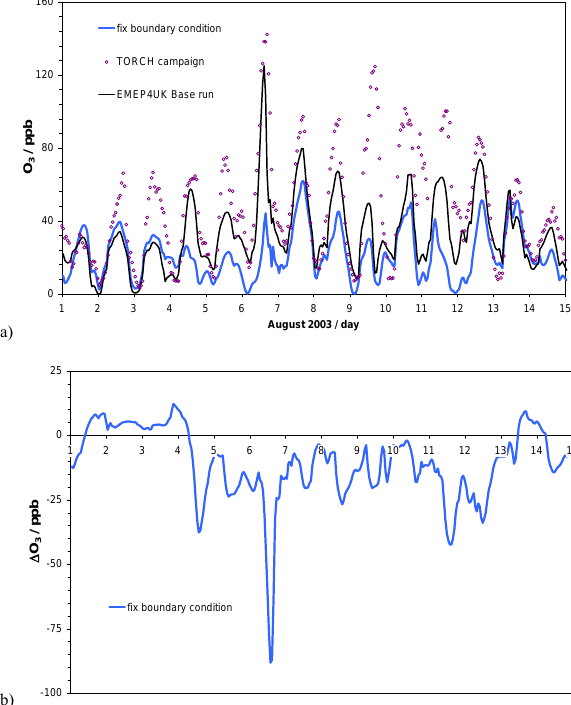
Figure 17: As for Figure 8, but for the model sensitivity experiment with fixed Fig. 17. As for Fig. 8, but for the model sensitivity experiment with (climatological) O 3 at the boundary of the EMEP4UK inner domain. fixed (climatological) O 3 at the boundary of the EMEP4UK inner